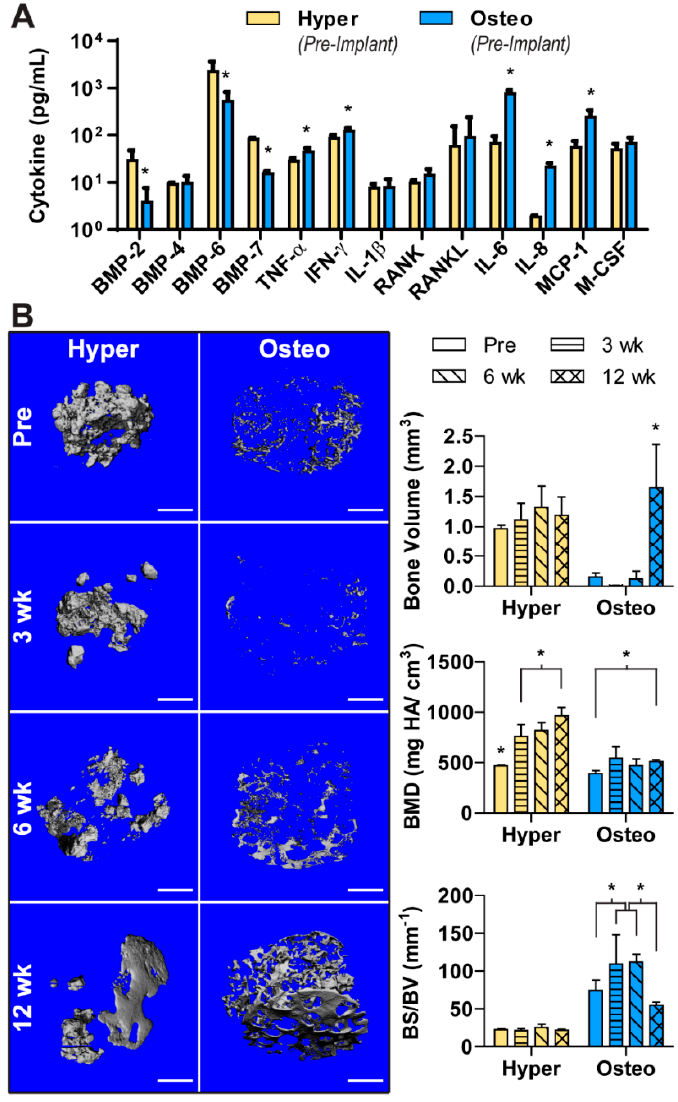
Figure 3. Cytokine release from constructs and in vivo bone formation. ( A ) Cytokines released into the culture medium. The hyper constructs released higher levels of BMP-2, BMP-6 and BMP-7 and lower levels of inflammatory (TNF- α , IFN- γ ) and degradation (IL-6, IL-8, MCP-1) cytokines compared with the osteo constructs. The release of BMP-4, IL-1ß, RANK, RANKl and M-CSF was comparable between the groups. ( B ) µCT of the constructs before implantation and following 3, 6 and 12 weeks of implantation. Scale bars: 1 mm. The total bone volume, BMD and BS/BV were determined for each group and timepoint. Data are shown as the average ± SD ( n = 4). * Significant differences between the groups ( p < 0.05).